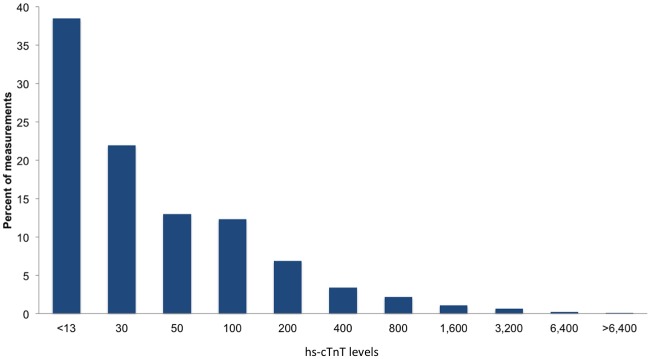
High sensitivity troponin value distribution.Distribution of hs-cTnT levels (expressed as ng/L) among 10,021 measurements. Only 38.4% of the measurements were below the 99th percentile.